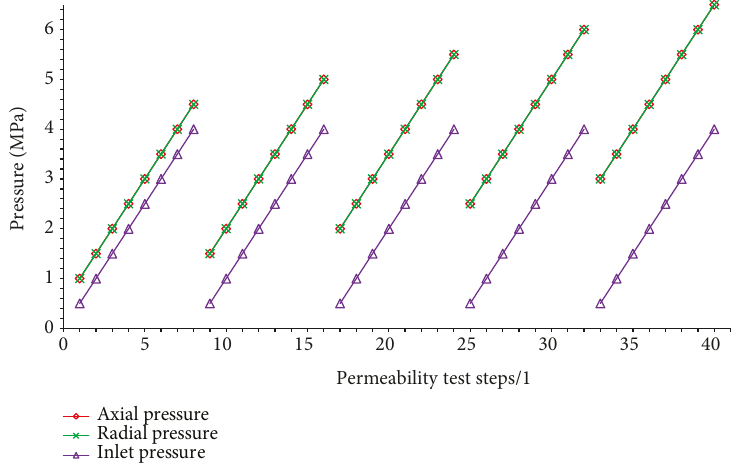
Figure 5: Tests on the pore pressure e ff ect on the permeability under constant inlet e ff ective stress.